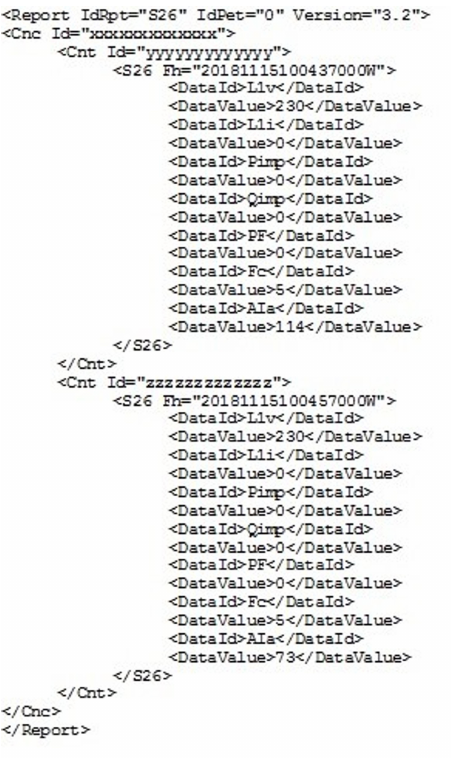
Figure 6. Values retrieved for two smart meters according to our program. Table 4. Results summary-variable: number of files received.